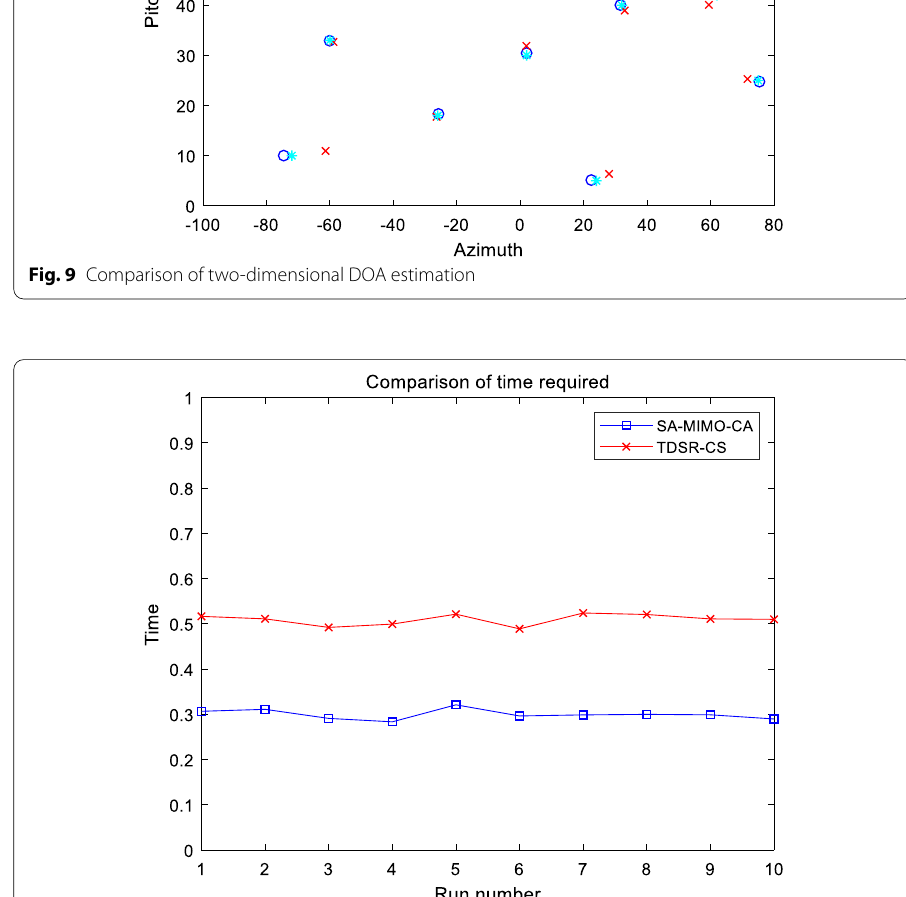
Fig. 10 Comparison diagram of the relationship between running times and